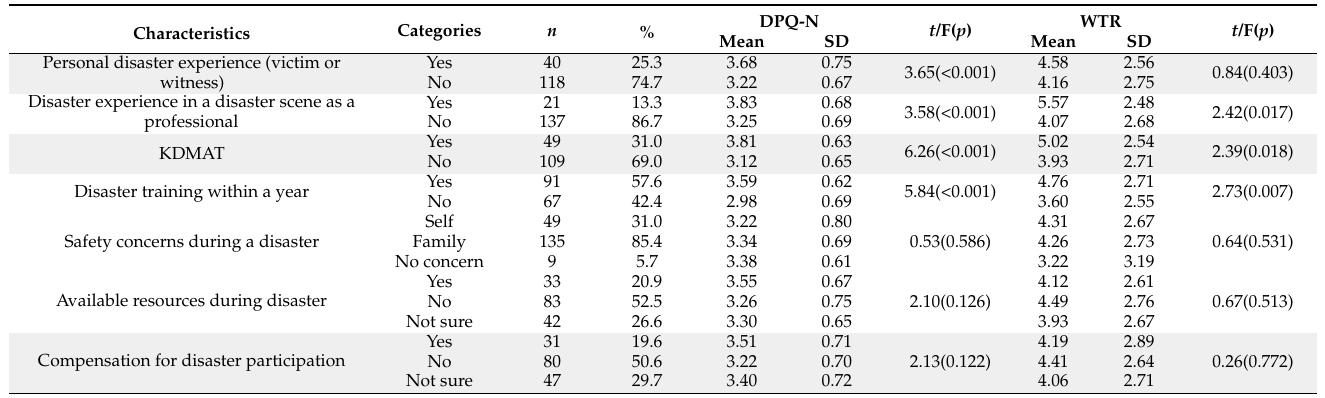
Table 2. Differences in disaster preparedness and WTR by disaster-related characteristics ( N =